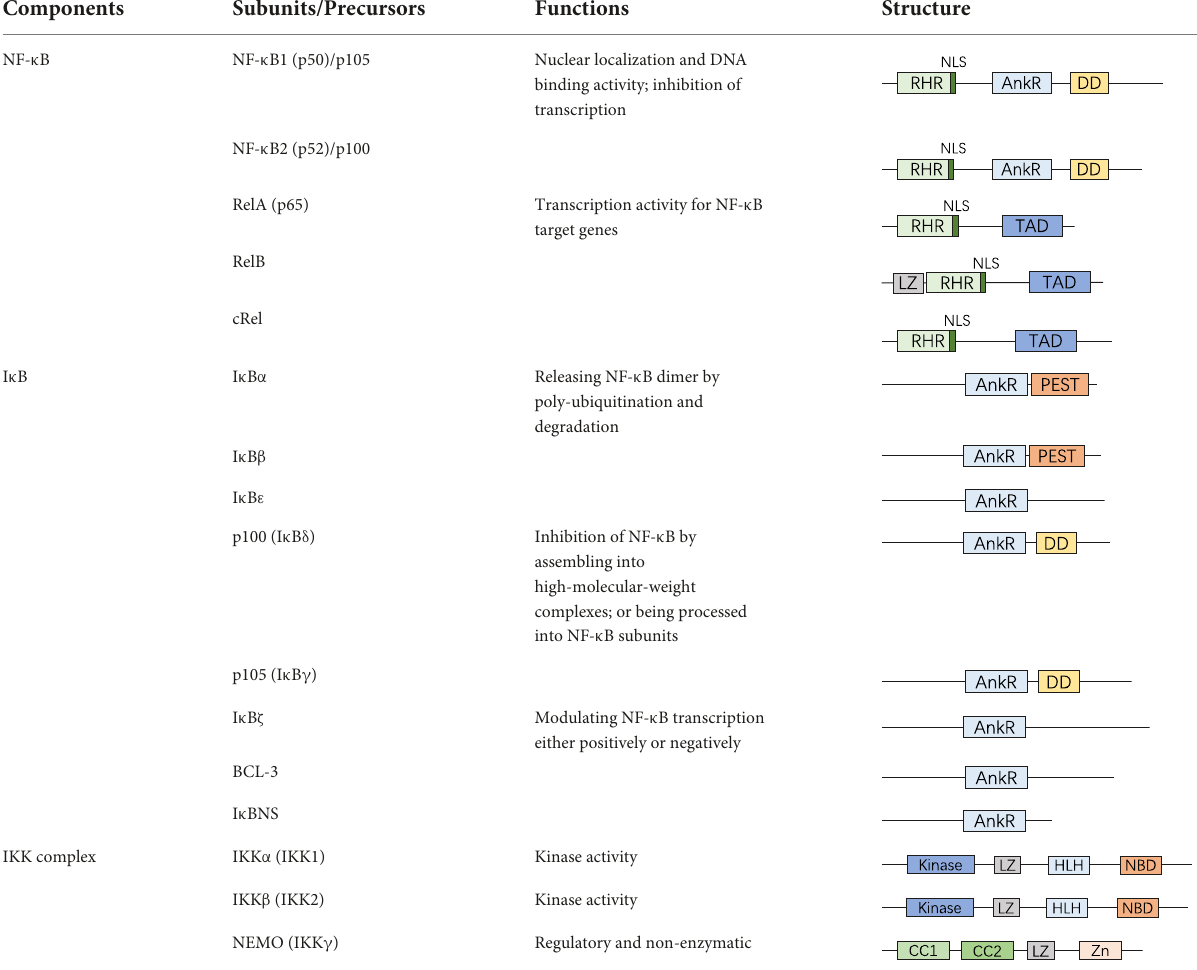
TABLE 1 Components and characteristics of the NF- κ B signaling